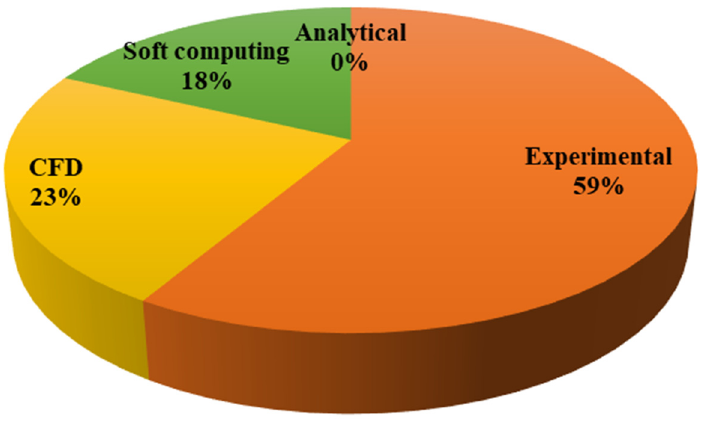
Figure 13. Methodologies used for active flow control.